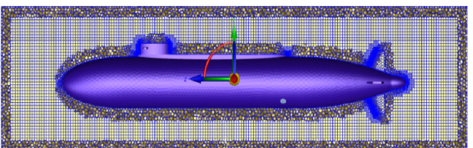
Figure 2. Grid division of submarine and nearby watershed.